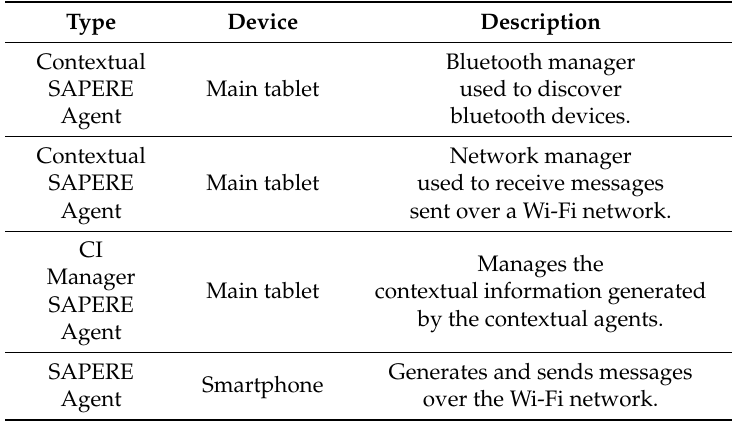
Table 4. List of SAPERE agents used in the